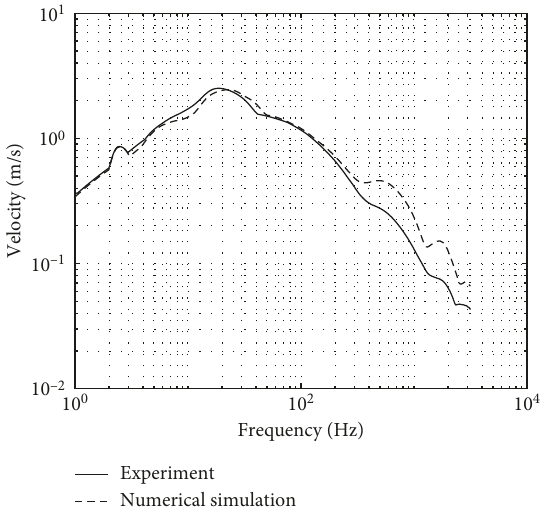
Figure 5: The results comparison of numerical simulation and